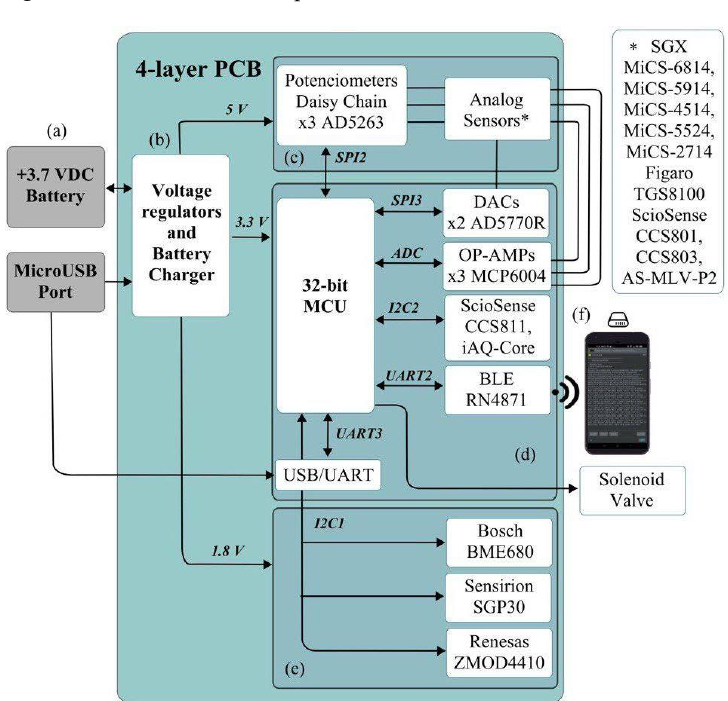
Figure 1. MultisensorNOSE top view.